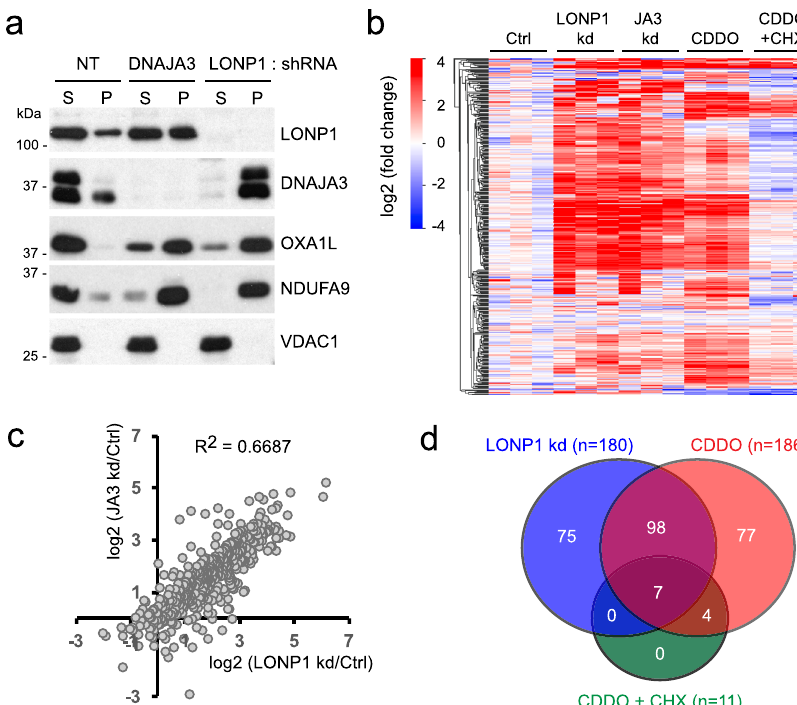
Fig. 2 Aggregation pro fi le of mitochondrial proteins in LONP1 or DNAJA3 knockdown and CDDO-treated cells. a Comparison of mitochondrial protein solubility in DNAJA3 and LONP1 knockdown cells. Cells were analyzed by Triton X-100 extraction and Western blotting. Note that the anti-DNAJA3 antibody recognizes a doublet, with both bands disappearing after DNAJA3 knockdown. NT: non-target. b , c Comparison of mass spectrometry data from three independent LONP1 knockdown, DNAJA3 (JA3) knockdown, CDDO alone and CDDO + cycloheximide (CHX)-treated mitochondria. LC-MS was used to identify proteins within detergent-insoluble pellets isolated from mitochondria. Clustered heatmap ( b ) and scatter plot ( c ) show the fold-change (compared to Ctrl) in insolubility of 445 mitochondrial proteins. d Venn diagram analysis of signi fi cantly aggregated proteins (at least 2-fold over control with a p -value <0.05) in LONP1-knockdown, CDDO alone and CDDO + CHX-treated mitochondria. Statistical analysis of proteins enriched in mitochondrial aggregates was performed using the LIMMA moderated two-tailed t